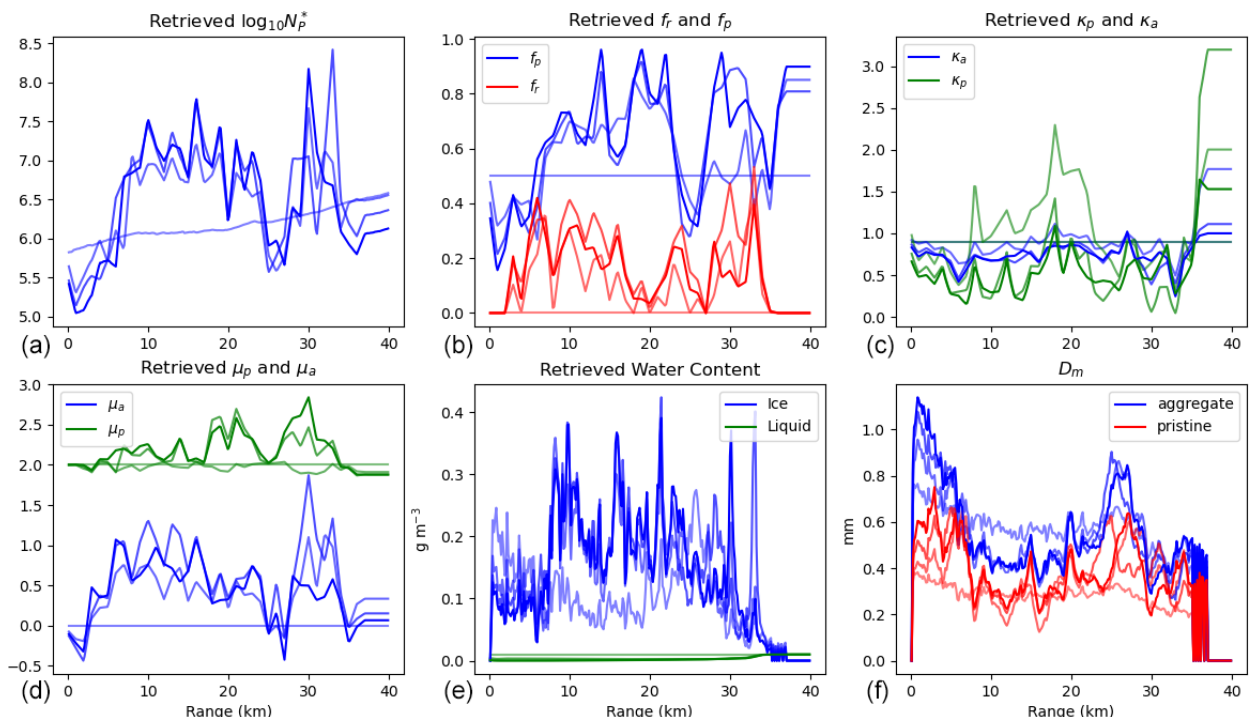
Figure 6. Retrieved N ∗ (a) , f r and f p (b) , κ p and κ a (c) , µ p and µ a (d) , water content (e) , and D m (f) from the D3R observations of Fig. 5. P As in Fig. 5, the retrieved measurements for each iteration are shown in progressively more opaque